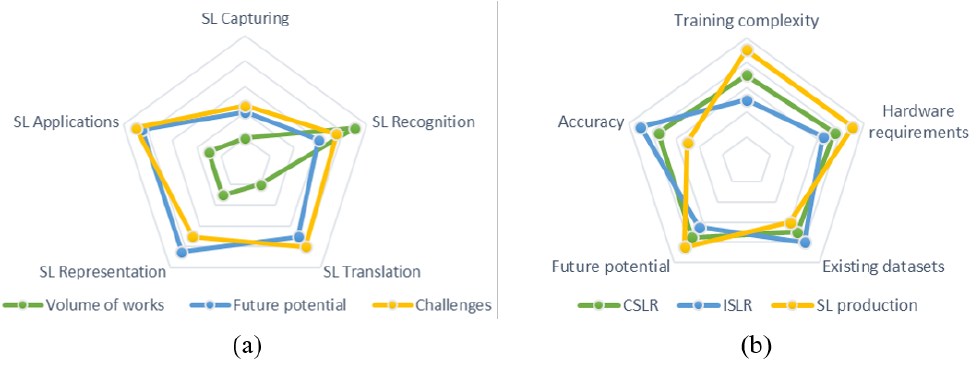
Figure 3. Radar charts showcasing the findings of this survey regarding ( a ) the literature methods for CSLR, ISLR and SLP and ( b ) the characteristics of each AI sign language